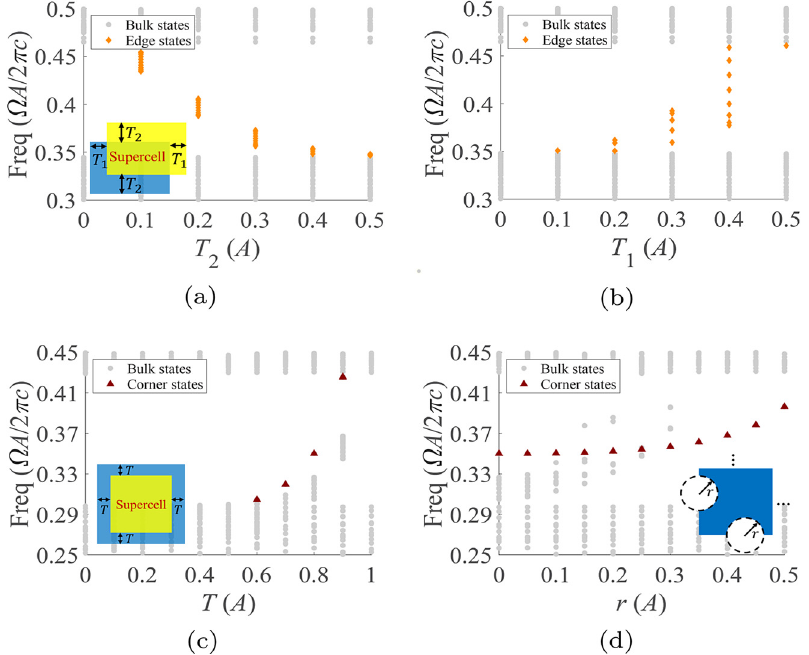
, 0). For example 2, (c) the supercell’s spectrum 1